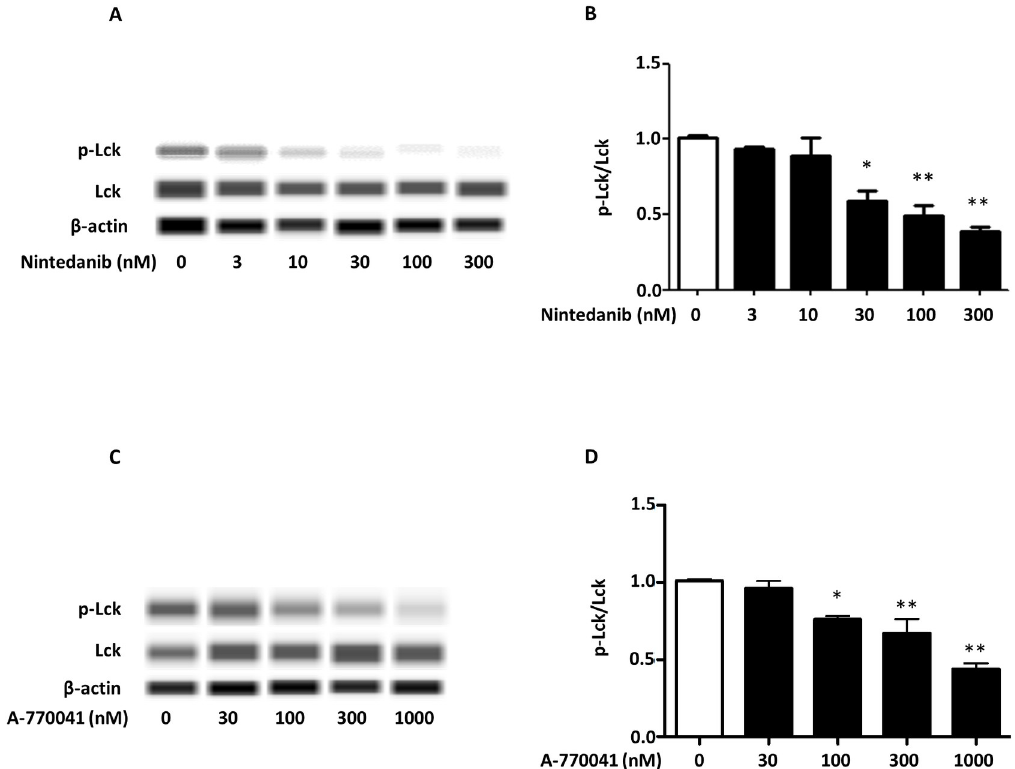
Fig 1. Nintedanib and A-770041 inhibit the phosphorylation of lymphocyte-specific protein tyrosine kinase (Lck) of murine CD4+ T-cells. CD4 + T-cells were collected from murine spleens using magnetic activated cell sorting. CD4 + T-cells were stimulated by anti-CD3/CD28 antibodies and incubated with different concentrations of nintedanib (0–300 nM) (A)(B) or A-770041 (0–1000 nM) (C)(D) for 5 minutes. The phosphorylation of Lck was analyzed by the Simple Wes TM system (n = 4). � p < 0.05 versus groups treated without nintedanib or A-770041; �� p < 0.01 versus groups treated without nintedanib or